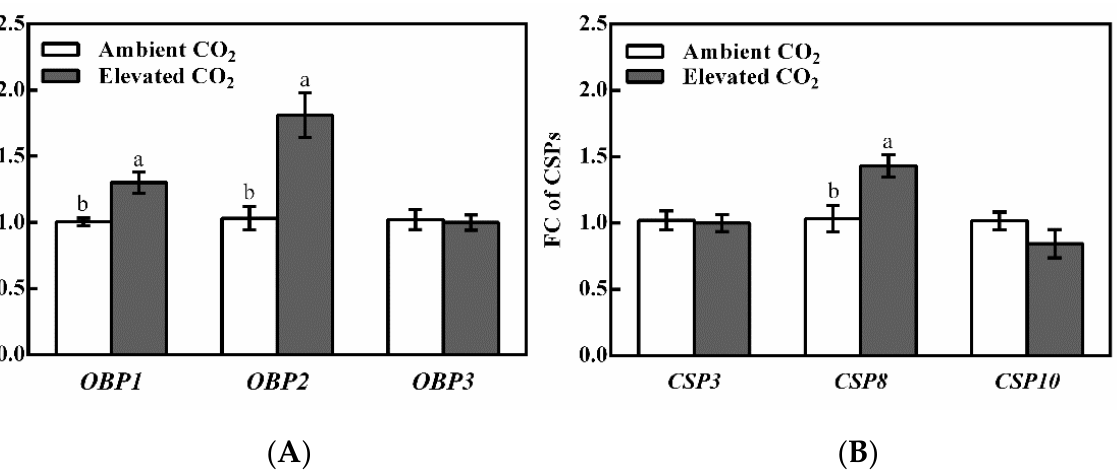
Figure 2. Relative gene expression levels of OBPs ( A ) and CSPs ( B ) in the adults of brown planthopper (BPH), N. lugens under ambient and elevated CO 2 . ( Note: Different lowercase letters indicate significant differences between ambient and elevated CO 2 level by the independent sample t -test at p < 0.05).